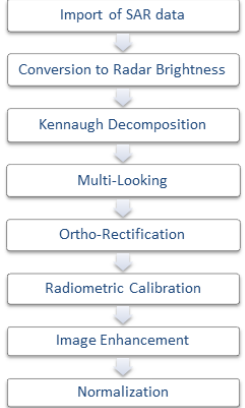
Figure 3. Production steps of the Multi-SAR